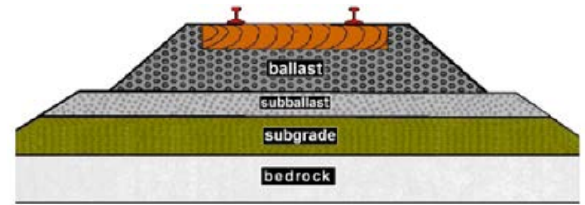
Figure 3: All-granular trackbed [6].